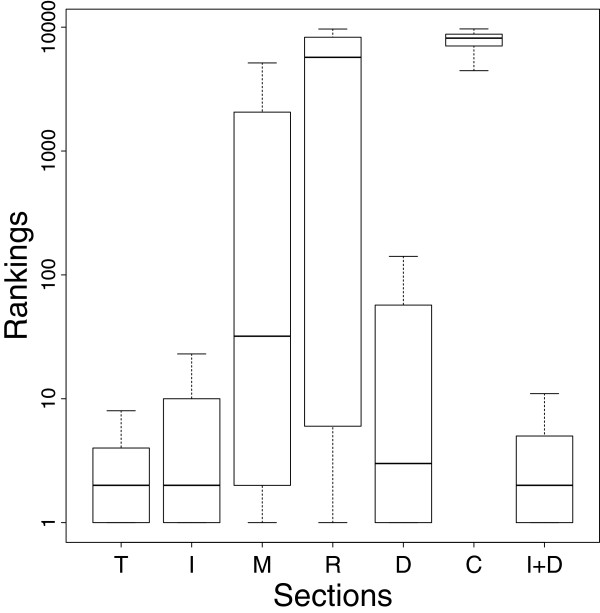
Classification of the citing document using cited references. The MedlineRanker algorithm was used to rank the citing document with respect to random ones using the references cited in the full document or its sections. Ranks were calculated by MedlineRanker for each document of a test set of 10,000 documents. T: total (or full document), I: introduction, M: methods, R: results, D: discussion, C: conclusion, and I+D: introduction and discussion.